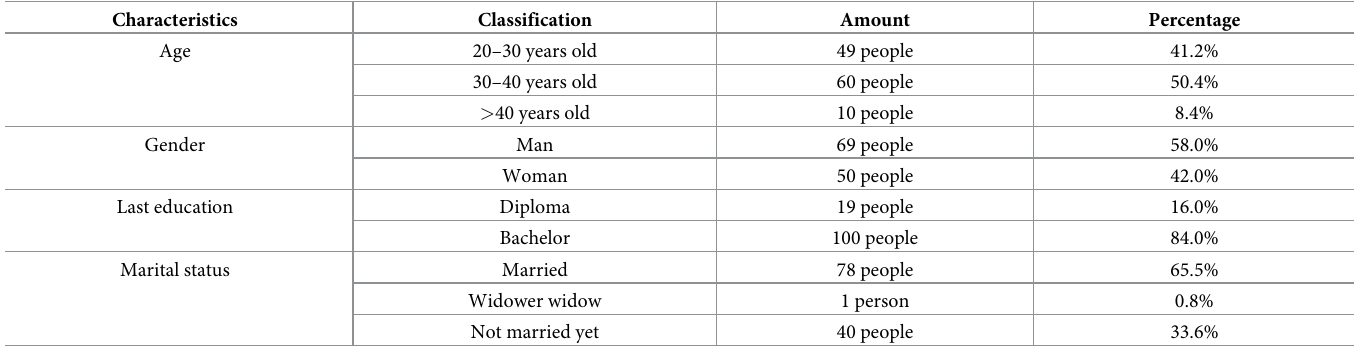
Table 1. Characteristics of